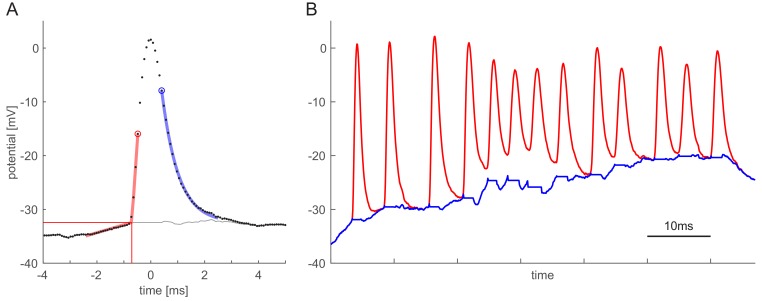
Spike fitting.(A) Location of a spike is determined by searching a local maximum (time axis aligned to this point for illustration purposes) in the raw membrane potential data (corresponding to peaks with steepness exceeding a given threshold). Inflection points before (right circle) and after (blue circle) the peak are determined. Initiation time of the spike (vertical thin red line), and the spike threshold (horizontal thin red line) are determined by a piecewise linear fit on the membrane potential in a time window preceding the left inflection point. The tail of the spike is fitted by an exponential (blue curve) on the time window between 2.5 ms succeeding the peak and the right inflection point. The fitted exponential is used for removing the spike tail in a 6 ms window. Between the starting point of the spike and the right inflection point the generator potential is taken to be equal to the spiking threshold. (B) Illustration of a high firing rate segment of the intracellular recording (red line) and the estimated generator potential (blue line). The spike fitting method is capable of estimating generator potentials for spikes separated by not less than 5 ms. The high firing rate shown here is not typical and was chosen to demonstrate the performance under circumstances that are challenging for spike fitting.